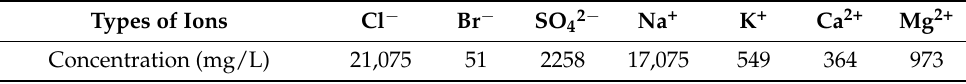
Table 2. Chemical composition of the seawater determined by ion chromatography.